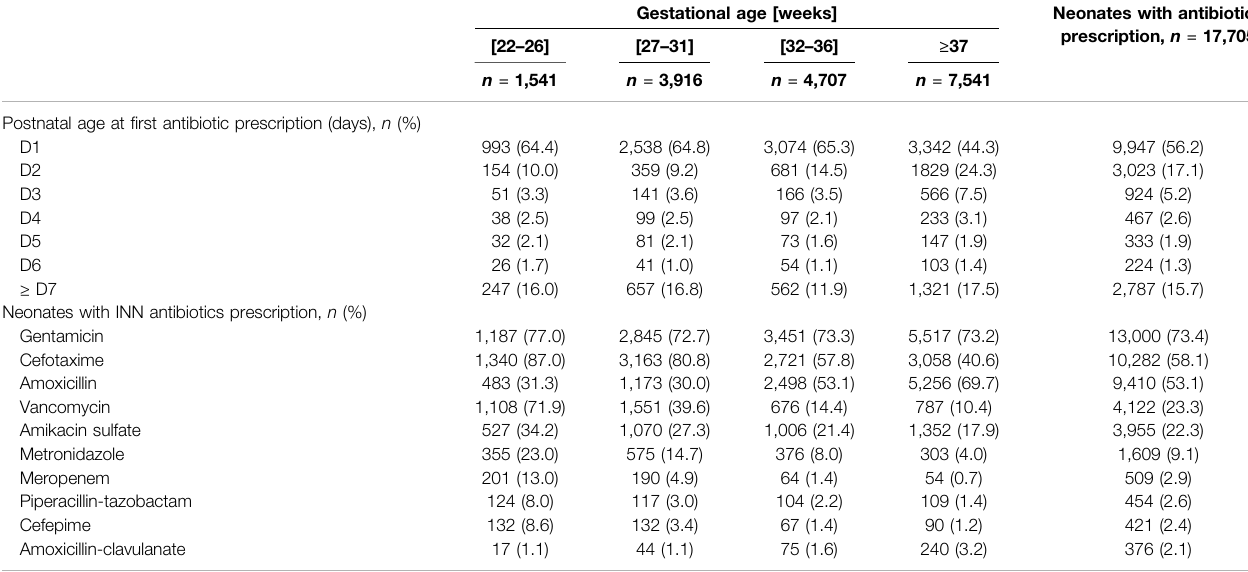
TABLE 2 | Postnatal age at fi rst prescription and top ten of INN antibiotics most prescribed.